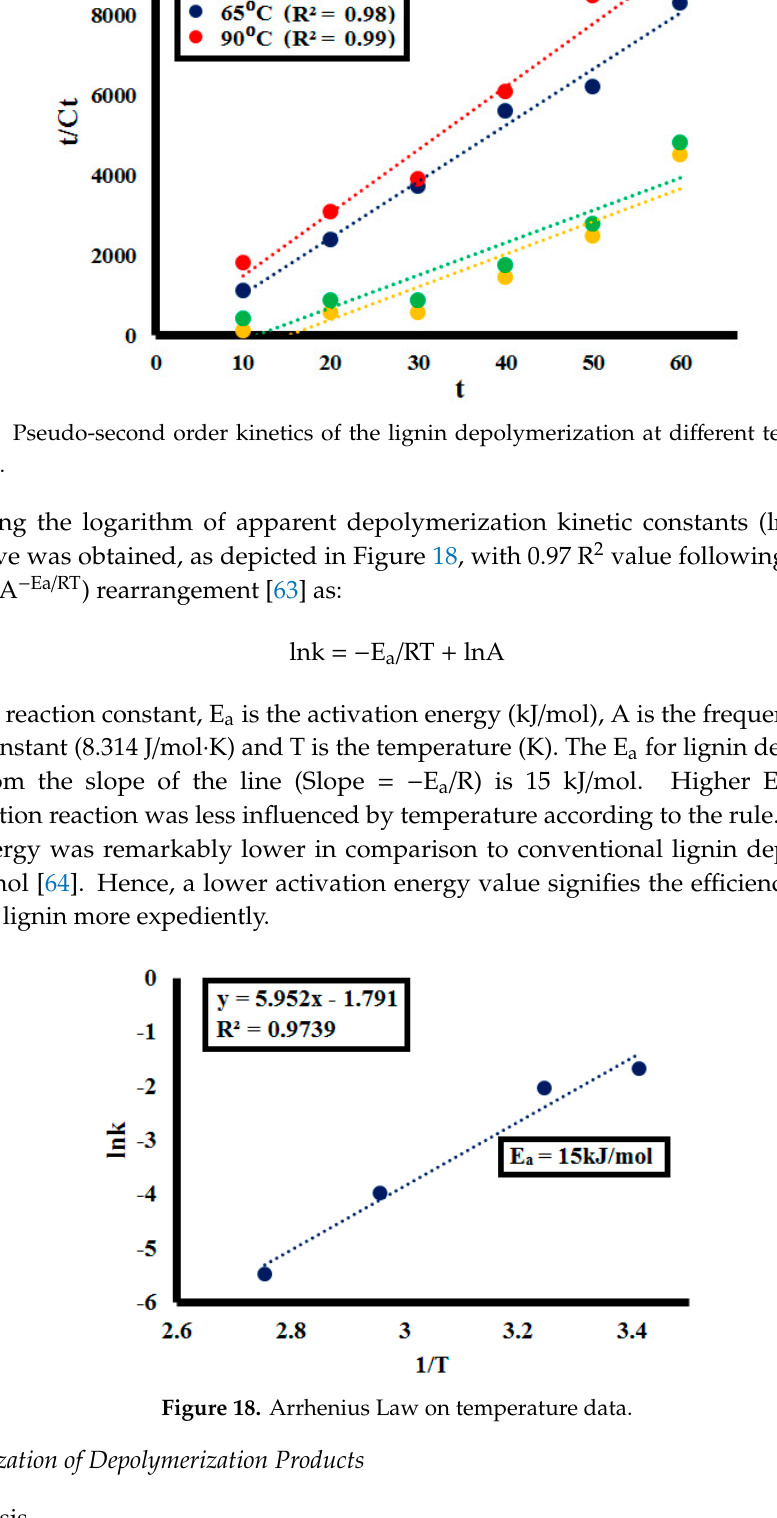
18 of 25 Table 6. Pseudo-second order kinetic parameters at different temperatures. Pseudo Second Order Kinetic Parameters at Different Temperatures